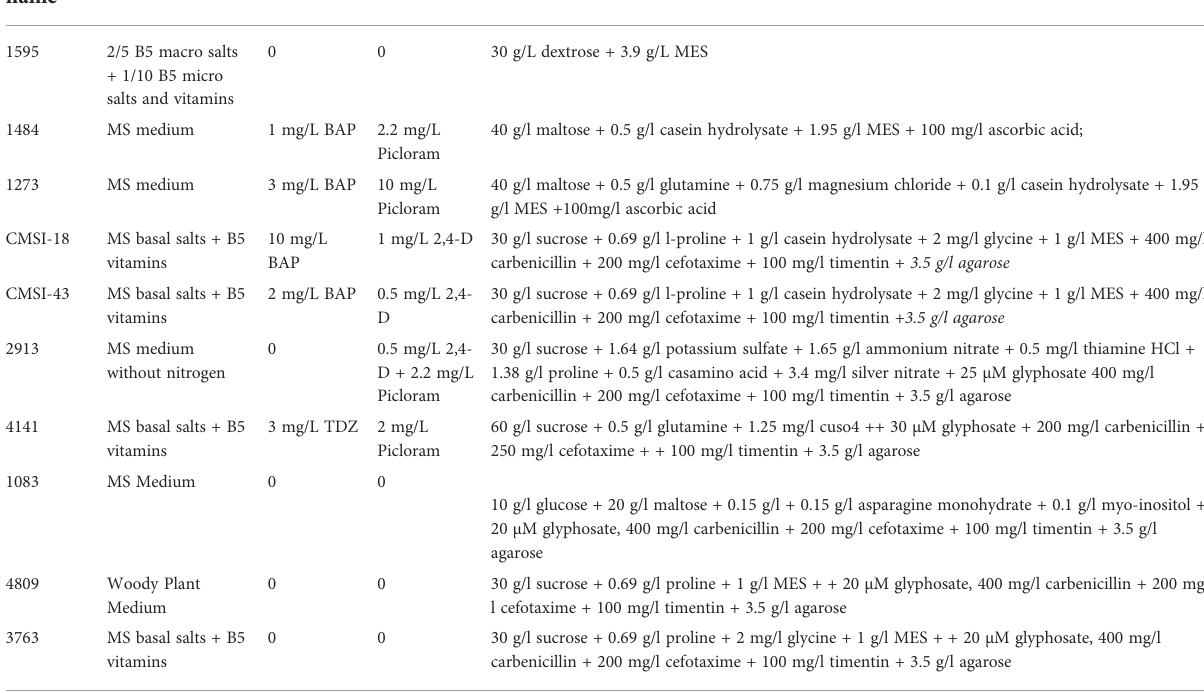
TABLE 1 Media used for transformation of maize mature seed embryo